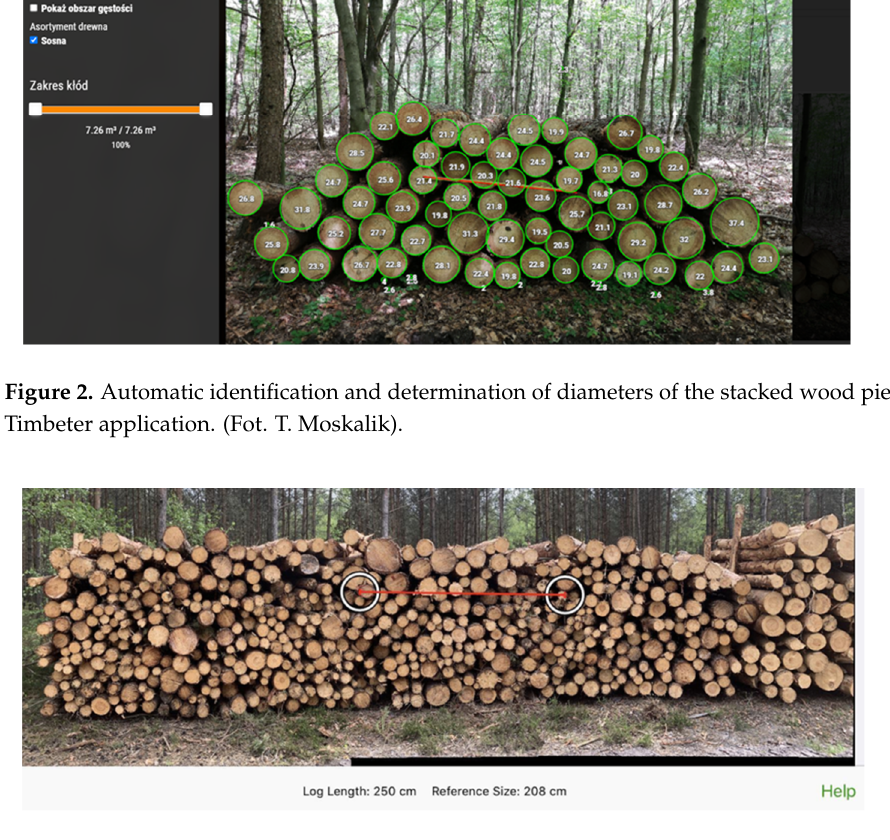
Figure 3. Setting the reference measurement in the Timbeter application. (Fot. M. Żak).